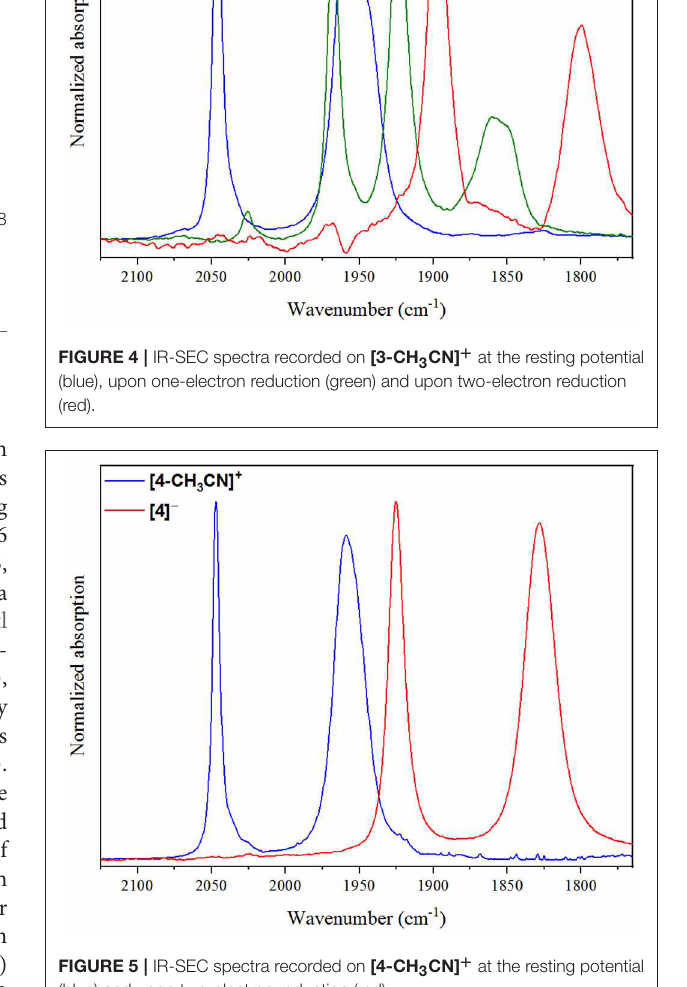
FIGURE 5 | IR-SEC spectra recorded on [4-CH 3 CN] + at the resting potential (blue) and upon two-electron reduction